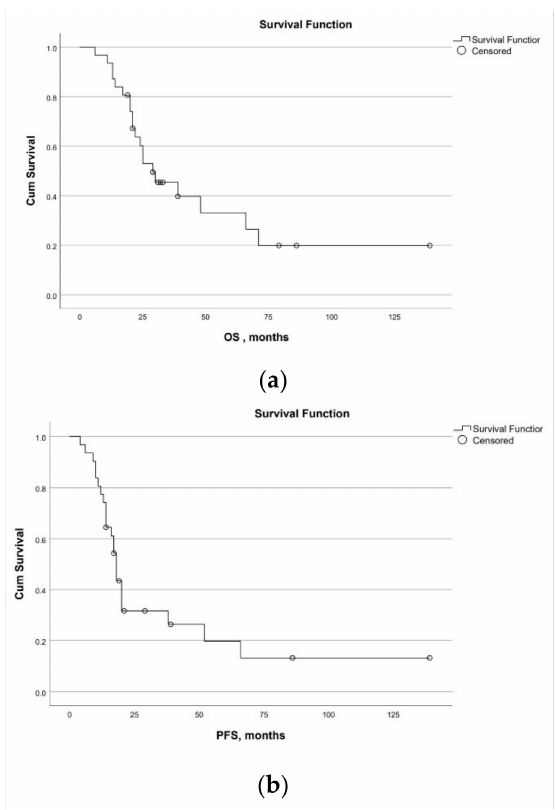
Figure 2. Survival of the patients with PDAC after Appleby procedures. ( a ) Overall survival; ( b ) Progression-free